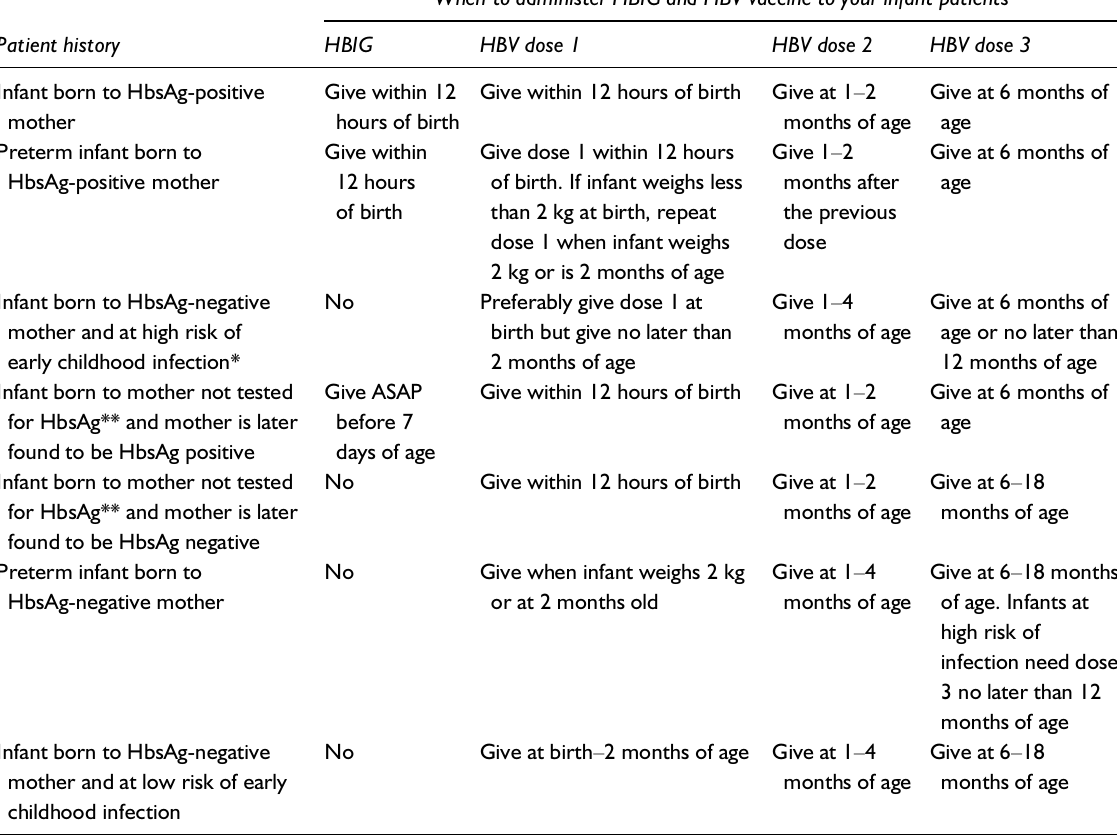
Table 2 Recommended hepatitis B (HBV) vaccination timings for infants. Engerix-B Ò (SmithKline Beecham, Rixensart, Belgium) and Recombivax HB Ò (Merck, Whitehouse Station, NJ) are the vaccine products available for use in the United States. Engerix-B and Recombivax HB single-antigen HBV vaccines are used for the birth dose and can also be used for all the remaining doses recommended for infants and